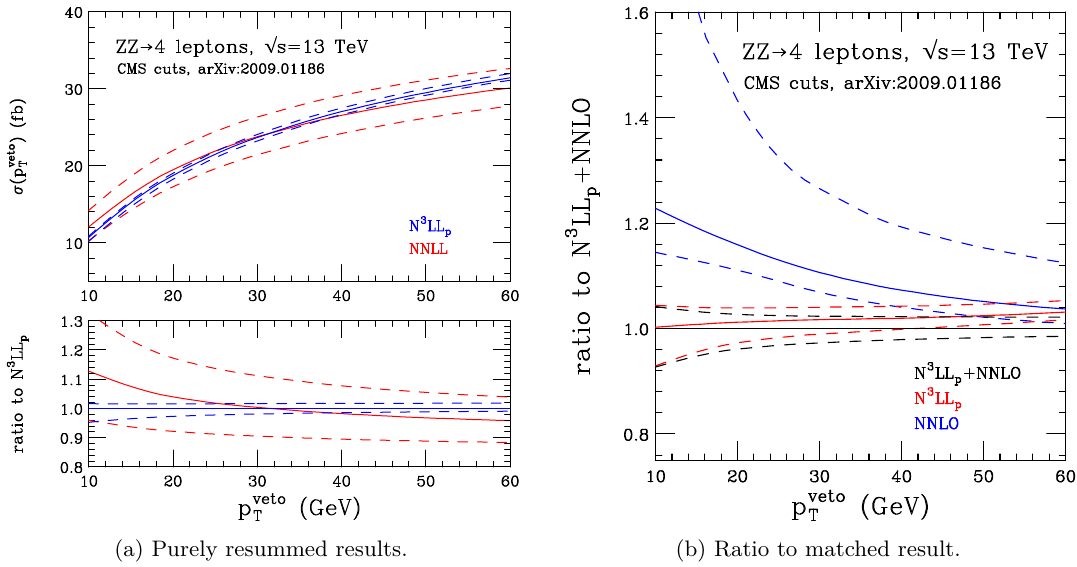
Figure 16 . Comparison of NNLO , N 3 LL p and matched N 3 LL p + NNLO results for ZZ production as a function of the jet